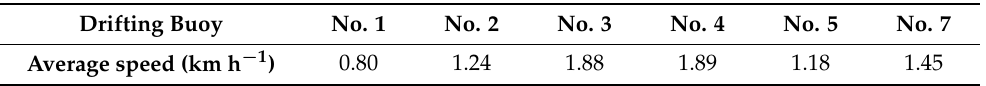
Table 5. List of average speed and moving